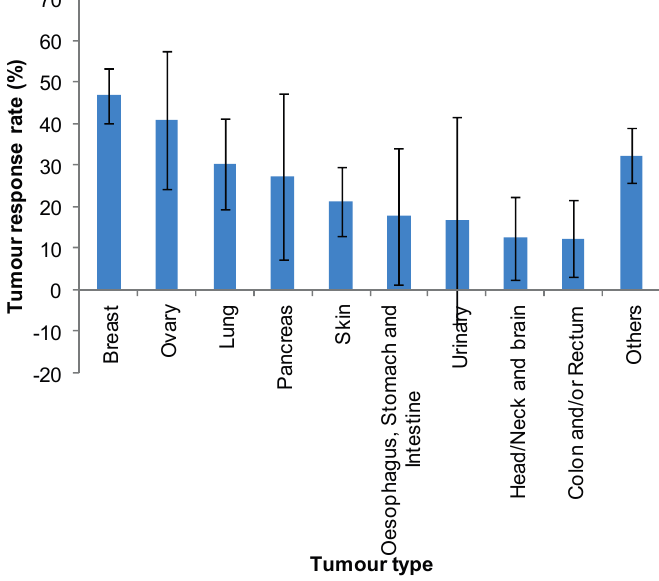
Figure 3. Graphical representation of the tumuor response rates for PDCs (release mediated only by cathepsin).